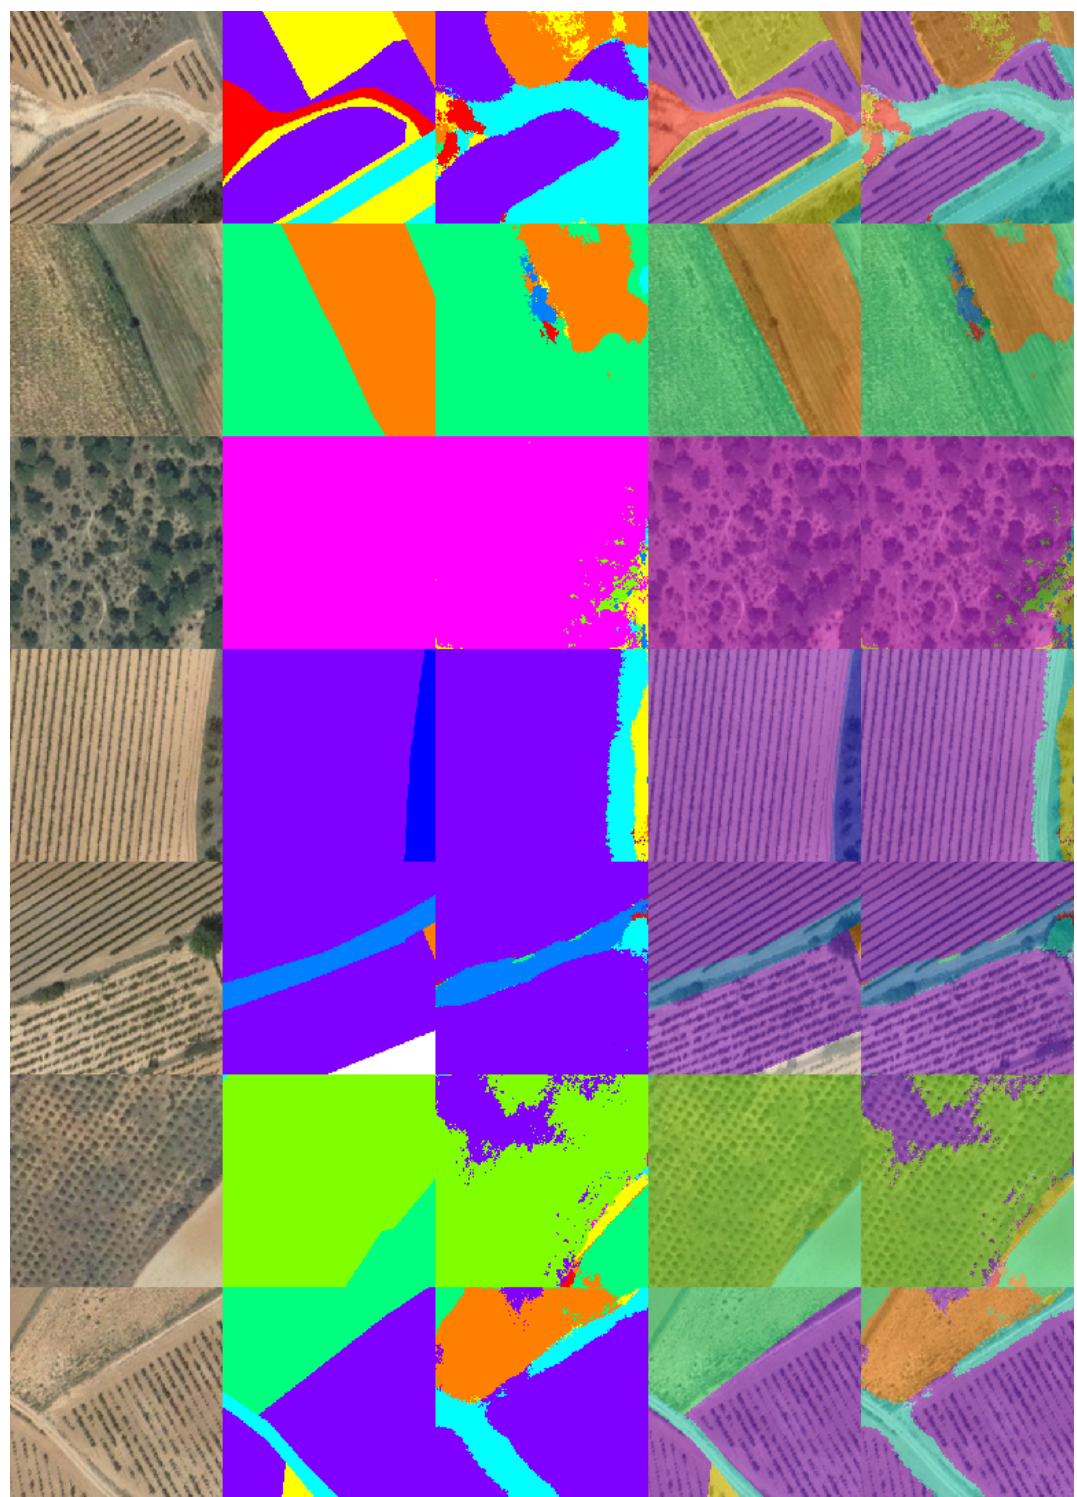
Figure 11. Visualization of the predicted results for UNet evaluated in UOPNOA (Experiment Base). ( 1st col. ) Original images, ( 2nd col. ) ground truth masks, ( 3rd col. ) predictions, ( 4th col. ) overlapping of original images with ground truth masks, ( 5th col. ) overlapping of original images with